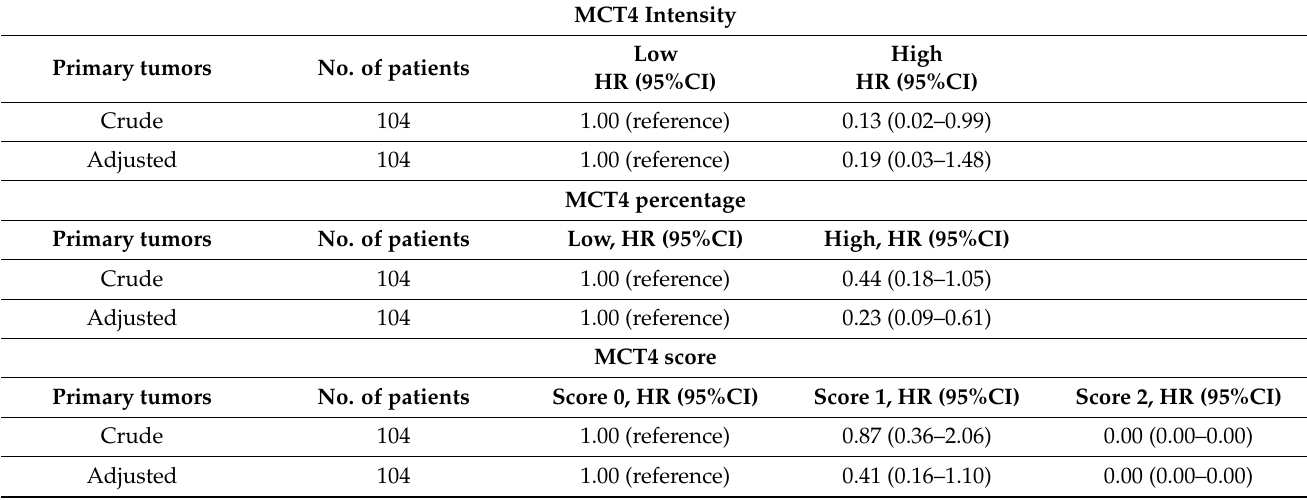
Table 4. Hazard ratios (HR) for disease-specific mortality with 95% confidence intervals (CI) in pri- mary small bowel neuroendocrine tumors stratified by MCT4 intensity (low/high), MCT4 percentage (low/high), and MCT4